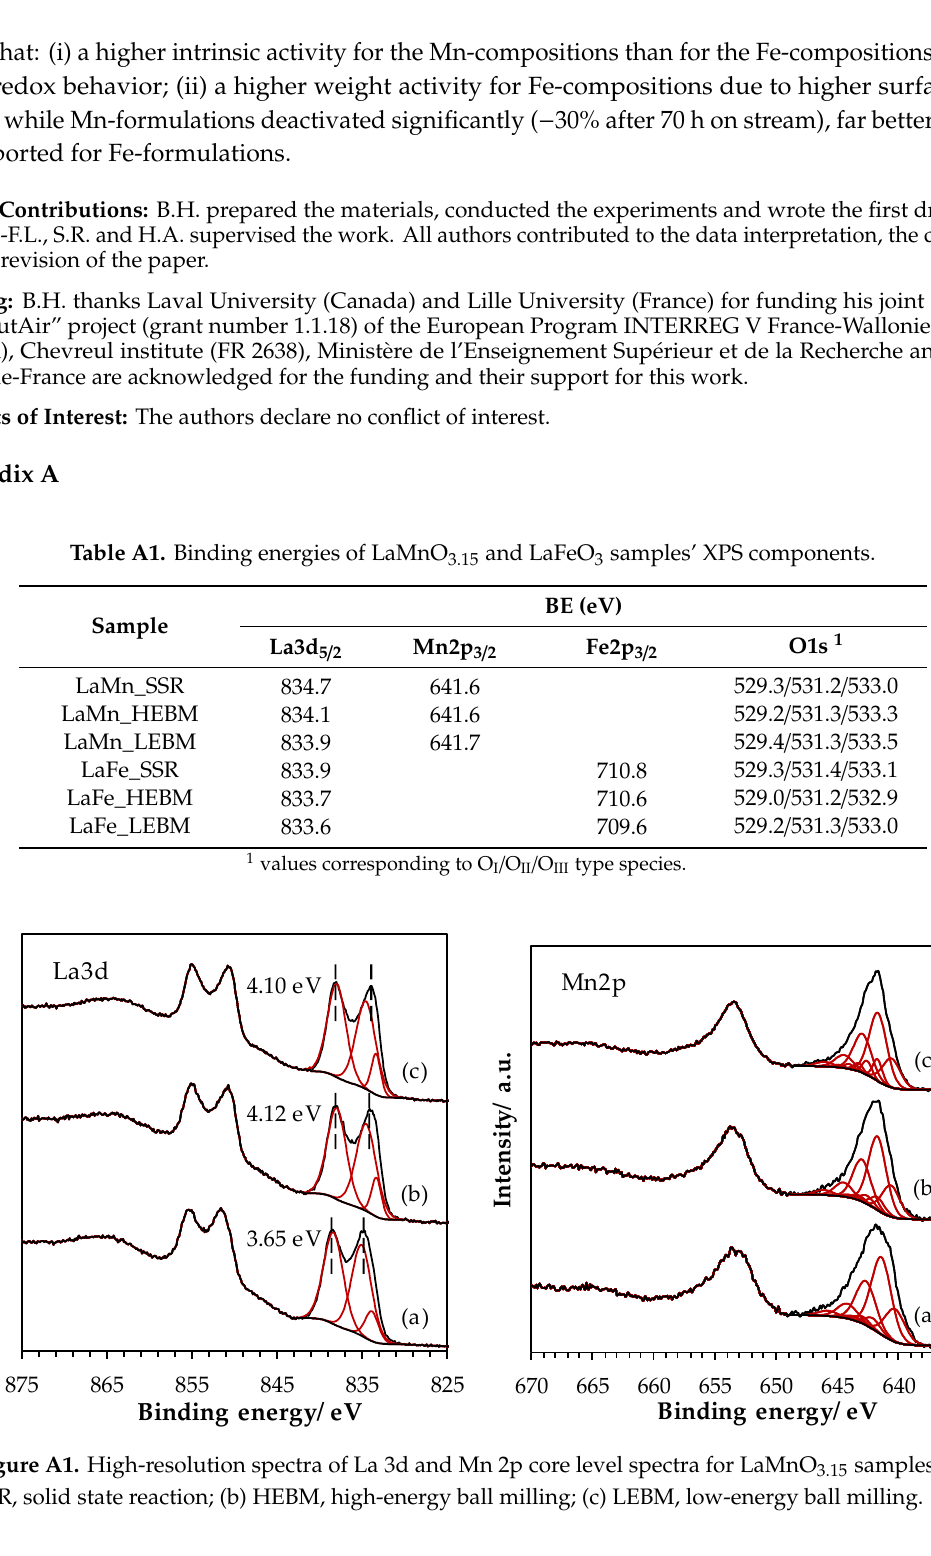
Figure A2. High-resolution spectra of La 3d core level spectra for LaFeO 3 samples: (a) SSR, solid state reaction; (b) HEBM, high-energy ball milling; (c) LEBM, low-energy ball milling. References